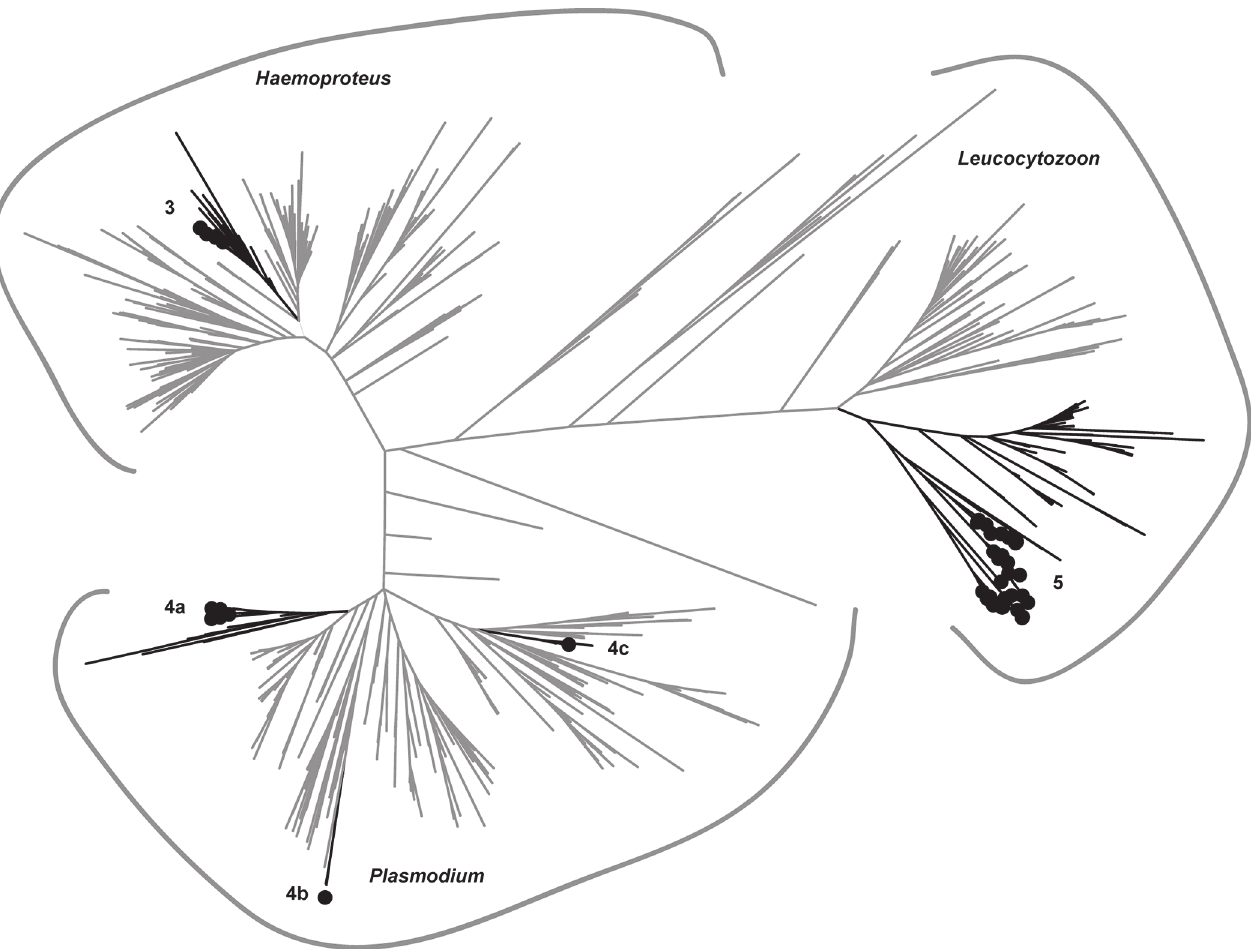
Fig 2. Maximum likelihood phylogenetic analysis of 1,124 haemosporidian sequences constructed from 386 base pairs of the Cytochrome b gene. Sequences detected in Pacific Americas Flyway ducks in this study are labeled with black circles; lineages (branches) that appear in sub-trees (Figs. 3 – 5) are shaded